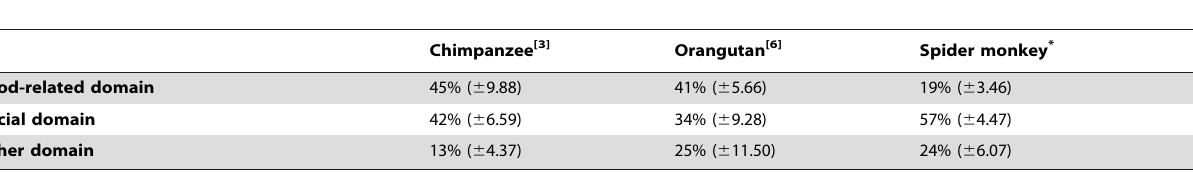
Table 2. Mean ( 6 SE) percentages of traditions across field sites in different domains for three primate species identified through cross-site